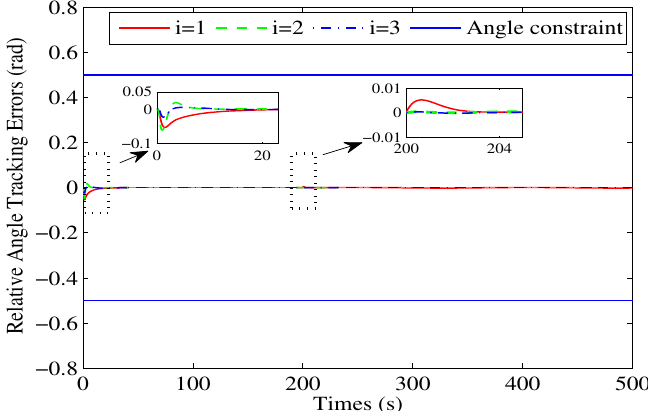
Figure 8. Yaw angle tracking errors along with proposed boundary.